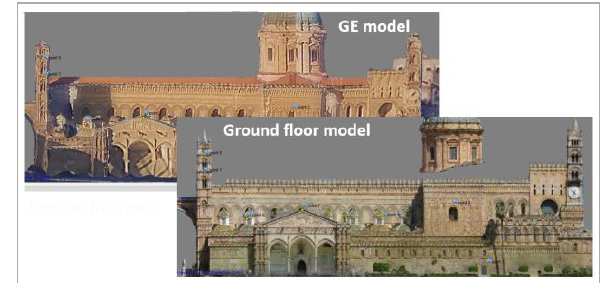
Figure 12. Detect Markers in Chunk 1 and Chunk 2